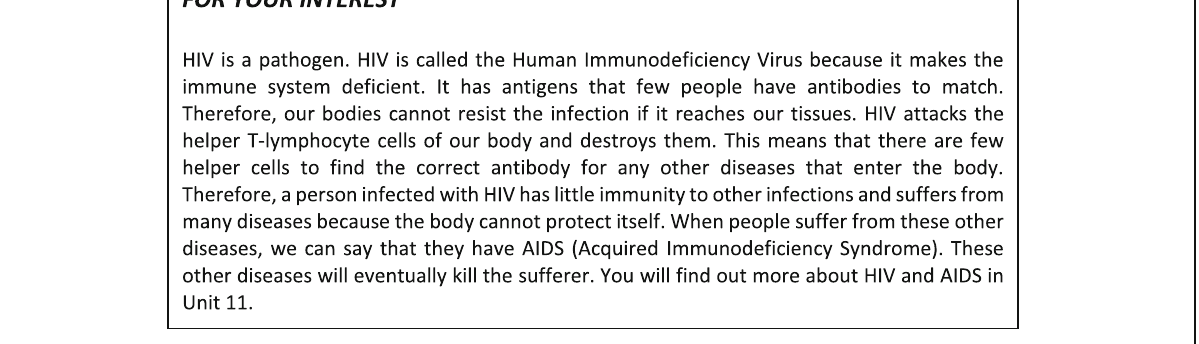
Fig. 2 An extract depicting how HIV/AIDS content is presented in a Life Sciences textbook (extracted from Ayerst et al., (2008, p.